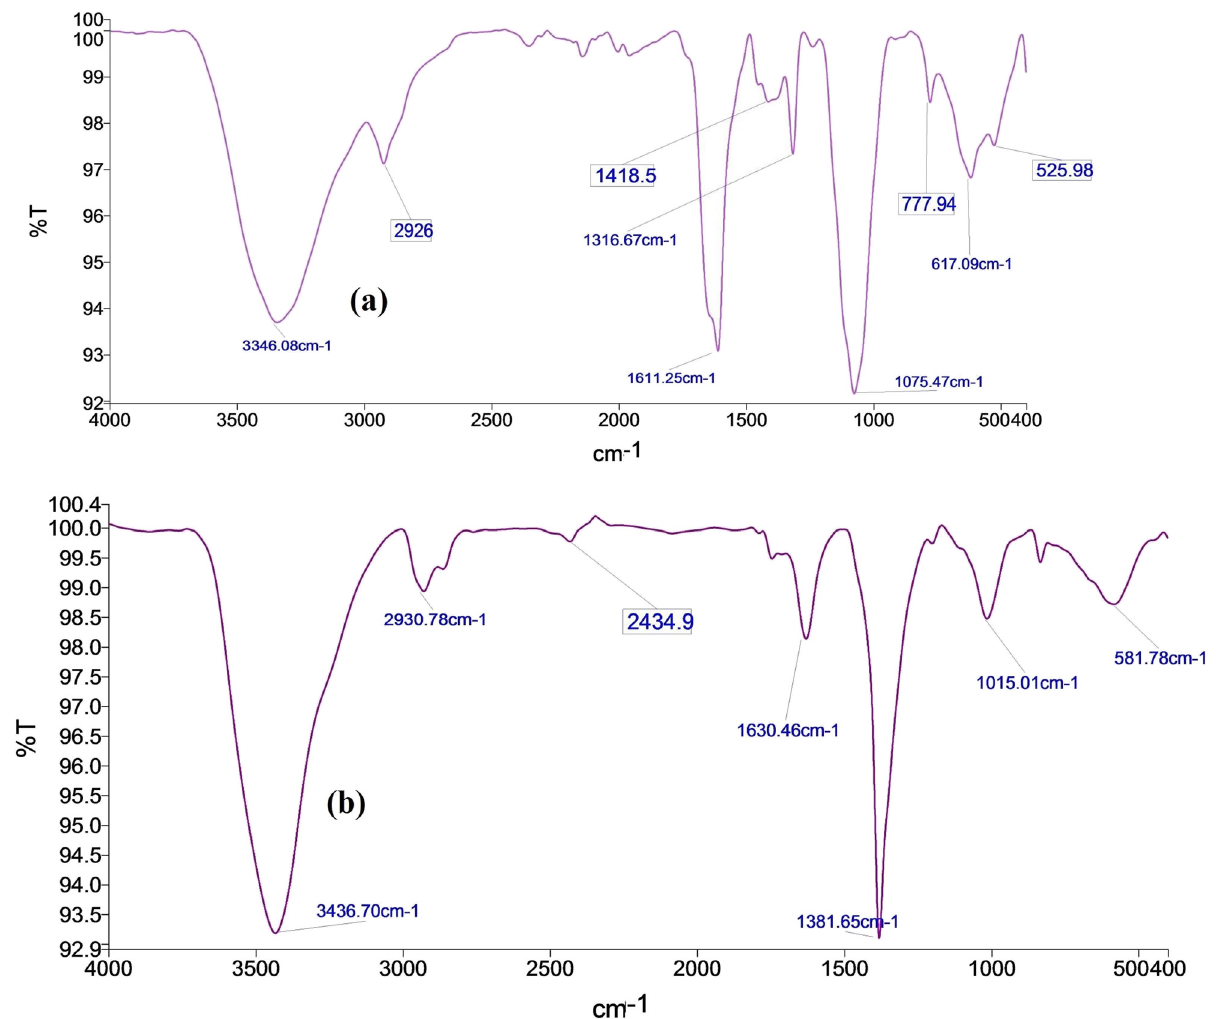
Figure 1: FT - IR spectra of the ( a ) extract of pista and ( b ) biosynthesized